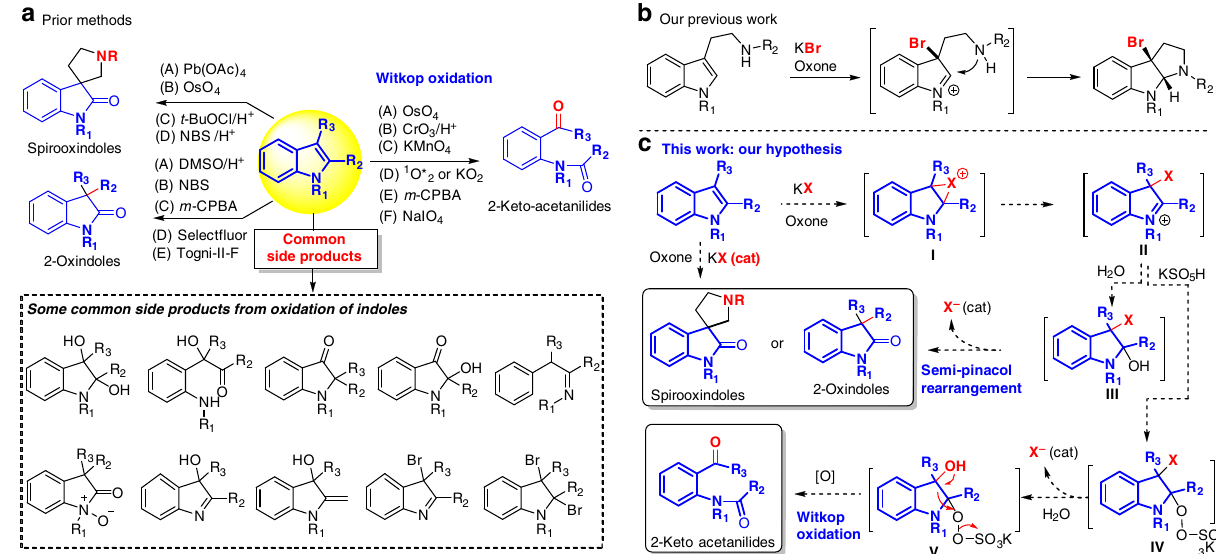
Fig. 1 Oxidation of indoles and our hypothesis. a Prior methods for oxidation of indoles and some common side products; ( b ) Our previous work. c Hypothesis of oxone-halide oxidation of indoles. NBS N-Bromosuccinimide; m -CPBA meta-Chloroperoxybenzoic